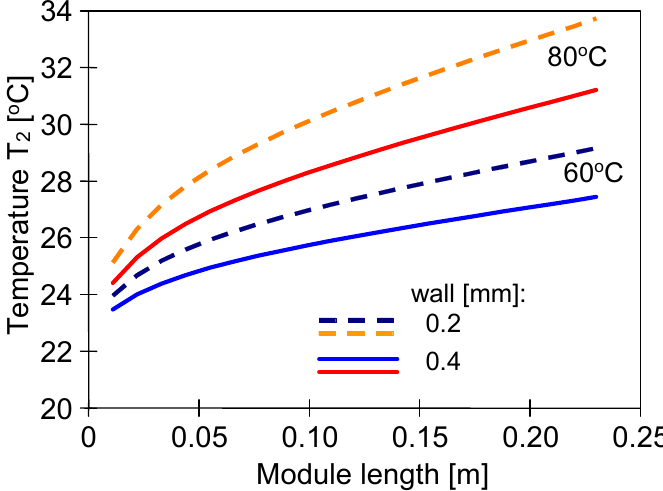
Figure 9. Changes in the interfacial surface temperature (T 2 ) on the distillate side calculated along the module’s length for feed temperatures 60 °C and 80 °C. Distillate inlet temperature T D = 22 °C. Membrane wall thickens at 0.2 and 0.4 mm.